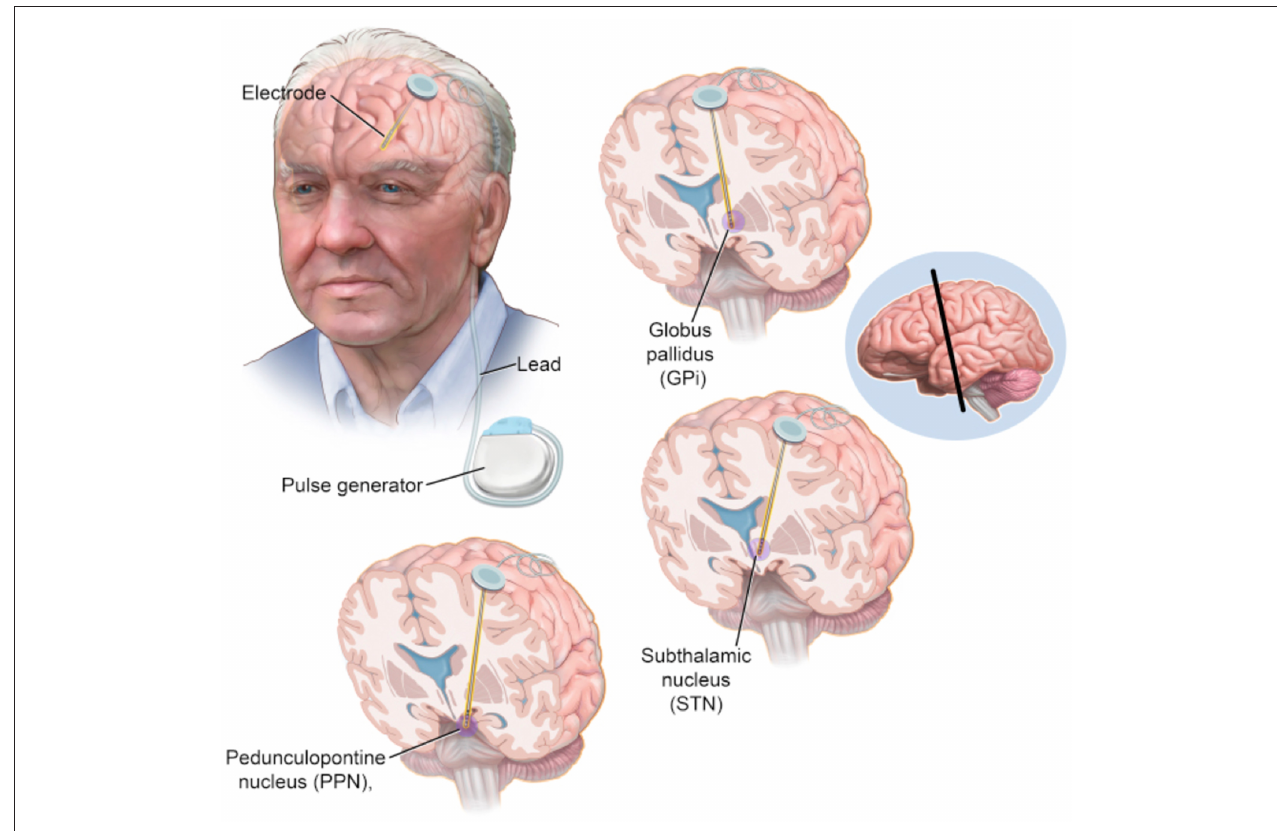
FIGURE 2 | Electrode Location for Deep Brain Stimulation. Approved locations for implantation of deep brain stimulation (DBS) include both the subthalamic nucleus and the internal segment of the globus pallidus. The pedunculopontine nucleus has showed promise as a potential DBS target, especially in regards to axial symptoms such as gait and balance dysfunction. During implantation, a burr hole is made in the skull through which the electrode is passed down to the target. An extension is tunneled under the skin of the scalp and connected to an impulse generator located in the chest below the clavicle.